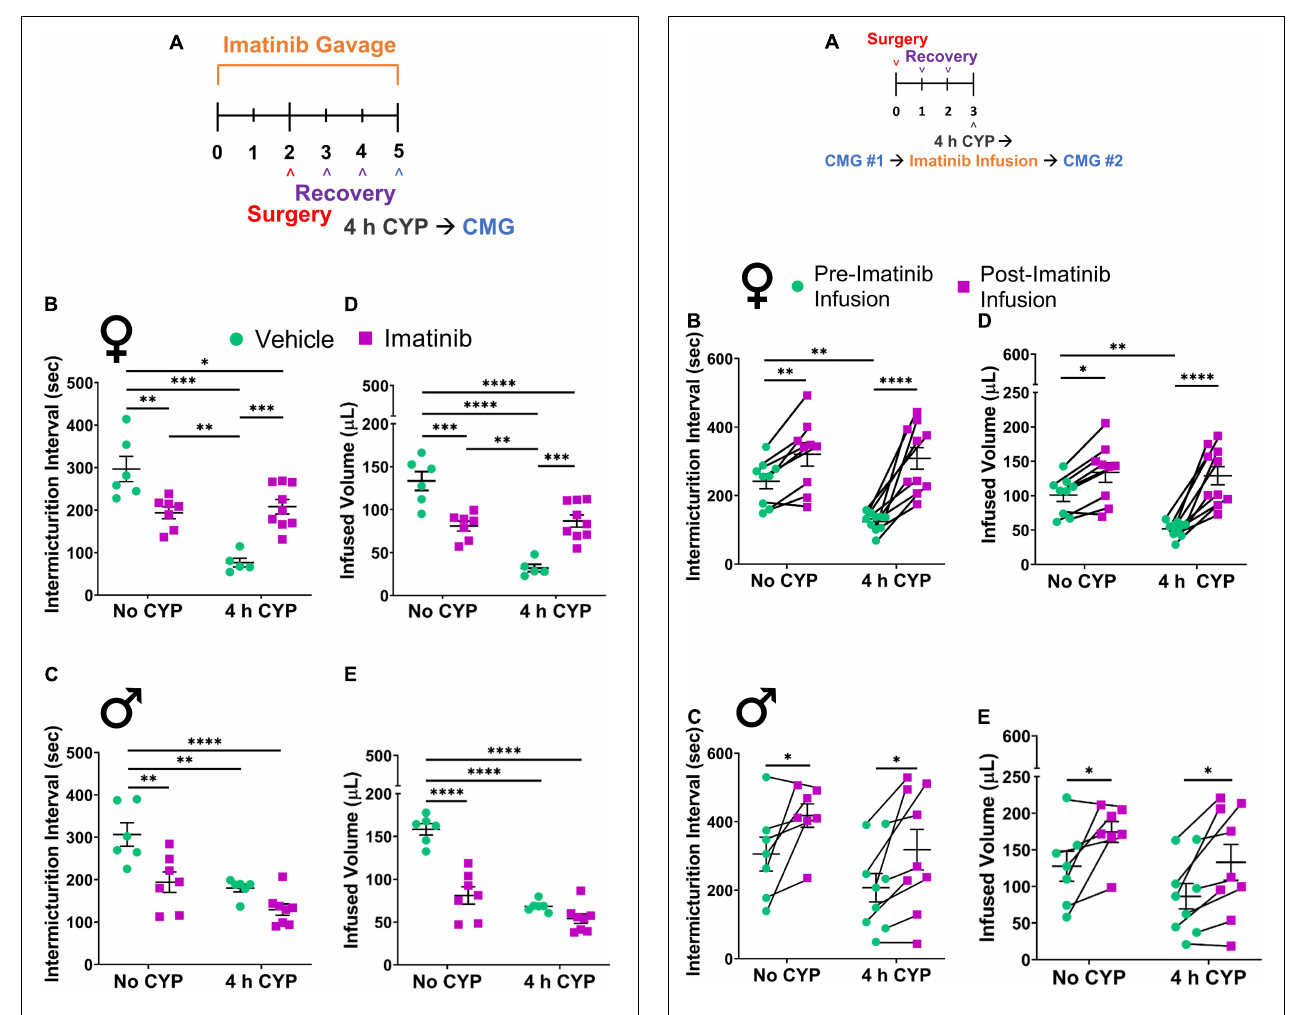
FIGURE 1 | Imatinib mesylate pre-treatment via oral gavage significantly alters intermicturition interval (IMI) and infused volume (IV) in an acute (4 h) cyclophosphamide (CYP)-induced cystitis mouse model. (A) Acute CYP-induced cystitis (200 mg/kg, 4 h, i.p.) experimental schedule for imatinib mesylate pre-treatment via oral gavage (250 mg/kg, 5 days, 1X/day). (B,D) Imatinib mesylate pre-treatment significantly increased IMI and IV ( p ≤ 0.001) in female mice with acute (4 h) CYP-induced cystitis. (C,E) Imatinib mesylate pre-treatment did not significantly affect bladder measures in male mice with acute CYP-induced cystitis. (B–E) Imatinib pre-treatment alone by gavage, without CYP, significantly (0.01 ≤ p ≤ 0.0001) decreased IMI and IV in both female and male mice, compared to vehicle treatment alone. n = 5–9. Values are mean ± SEM. ∗ p ≤ 0.05; ∗∗ p ≤ 0.01; ∗∗∗ p ≤ 0.001; ∗∗∗∗ p ≤ 0.0001 by two-way ANOVA with Bonferroni’s multiple comparisons test. CMG, cystometrogram.